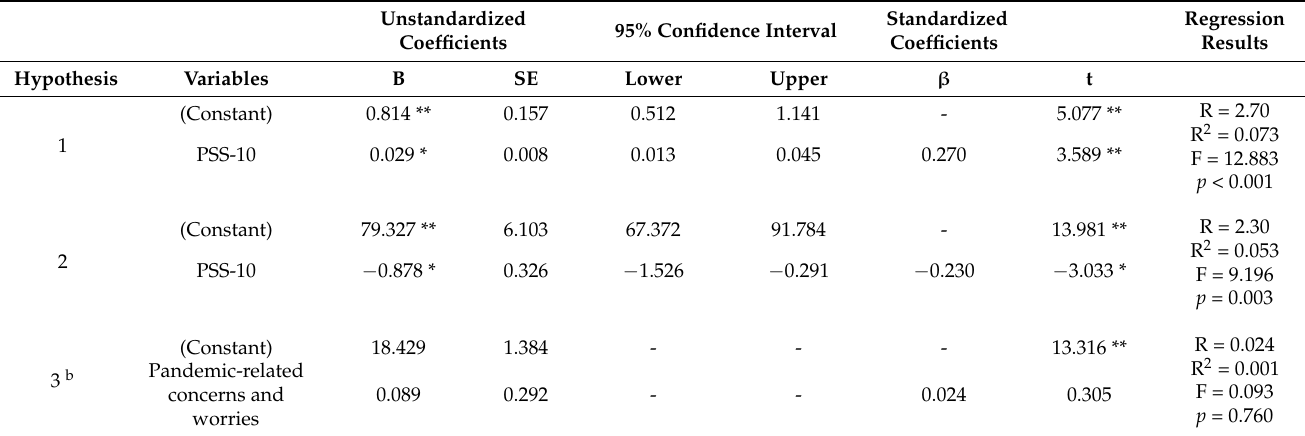
Table 3. Linear regression modelling, ( n =